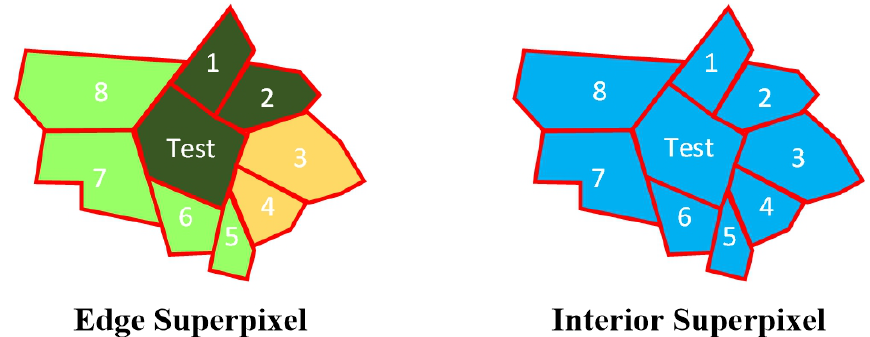
Figure 3. Edge superpixel and interior superpixel surrounded by neighbor superpixels (different colors represent different labels): (1) edge superpixel is the Test superpixel with green color surrounded by superpixels with different colors; and (2) interior superpixel is the Test superpixel with blue color surrounded by superpixels with same